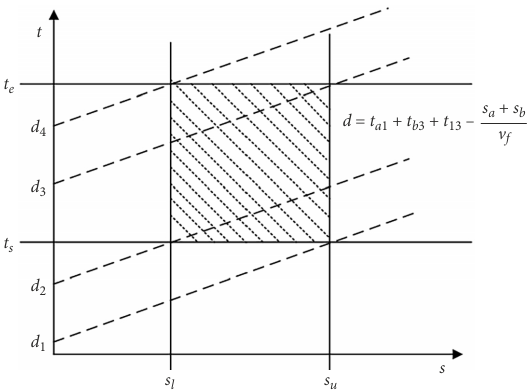
Figure 4. Probability change for different control delay value